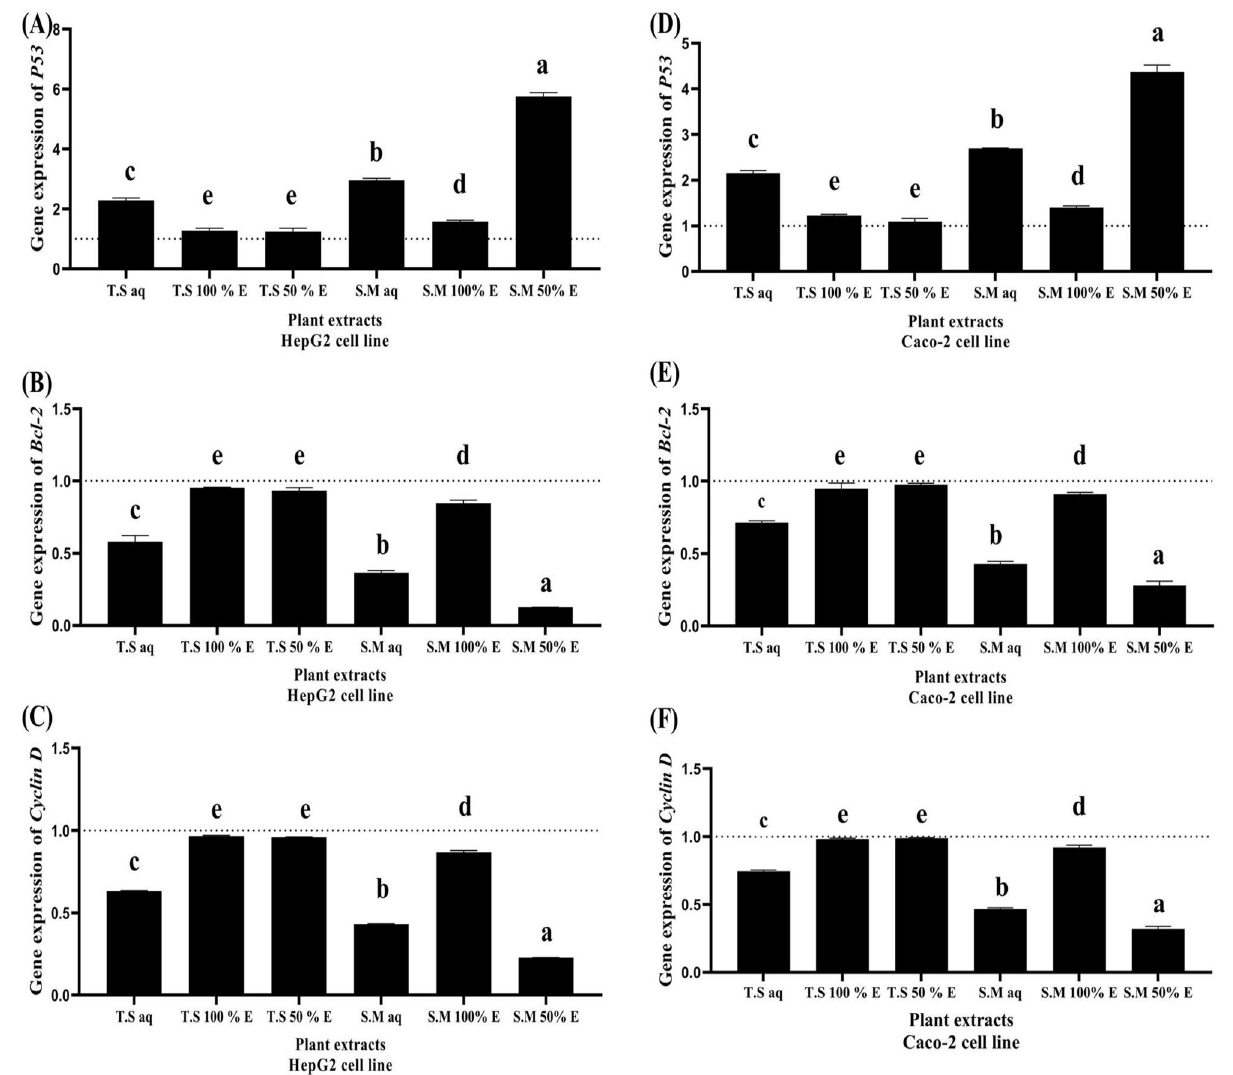
Figure 6. The effect of different aqueous, 100% EE and 50% EE Salix mucronata and Tritticum spelta plant extracts treated HepG2 and Caco-2 cancer cell lines on P53 , BCL2 and Cyclin D expression level ( A ) p53 expression level in treated HepG2 cancer cell line ( B ) BCL2 expression level in treated HepG2 cancer cell line ( C ) Cyclin D expression level in treated HepG2 cancer cell line ( D ) p53 expression level in caco-2 cancer cell line ( E ) BCL2 expression level in caco-2 cancer cell line ( F ) Cyclin D expression level in caco-2 cancer cell